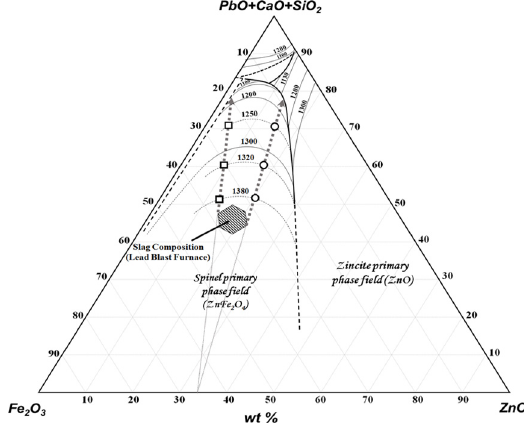
O ”-ZnO-(PbO-CaO-SiO 2 3